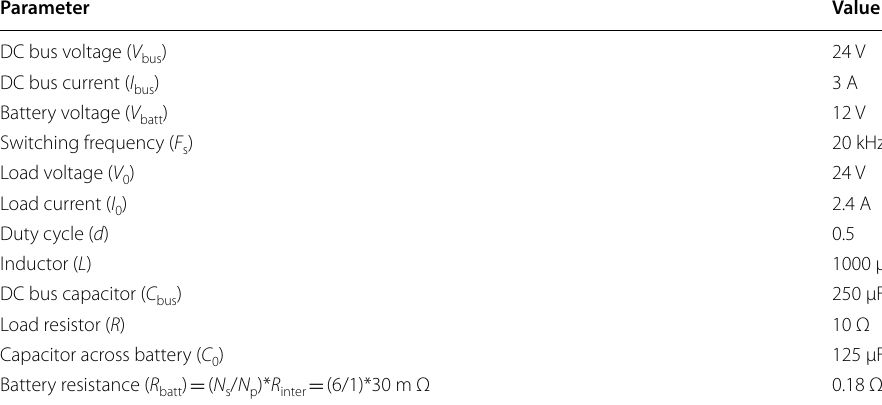
Table 1 Specifications of